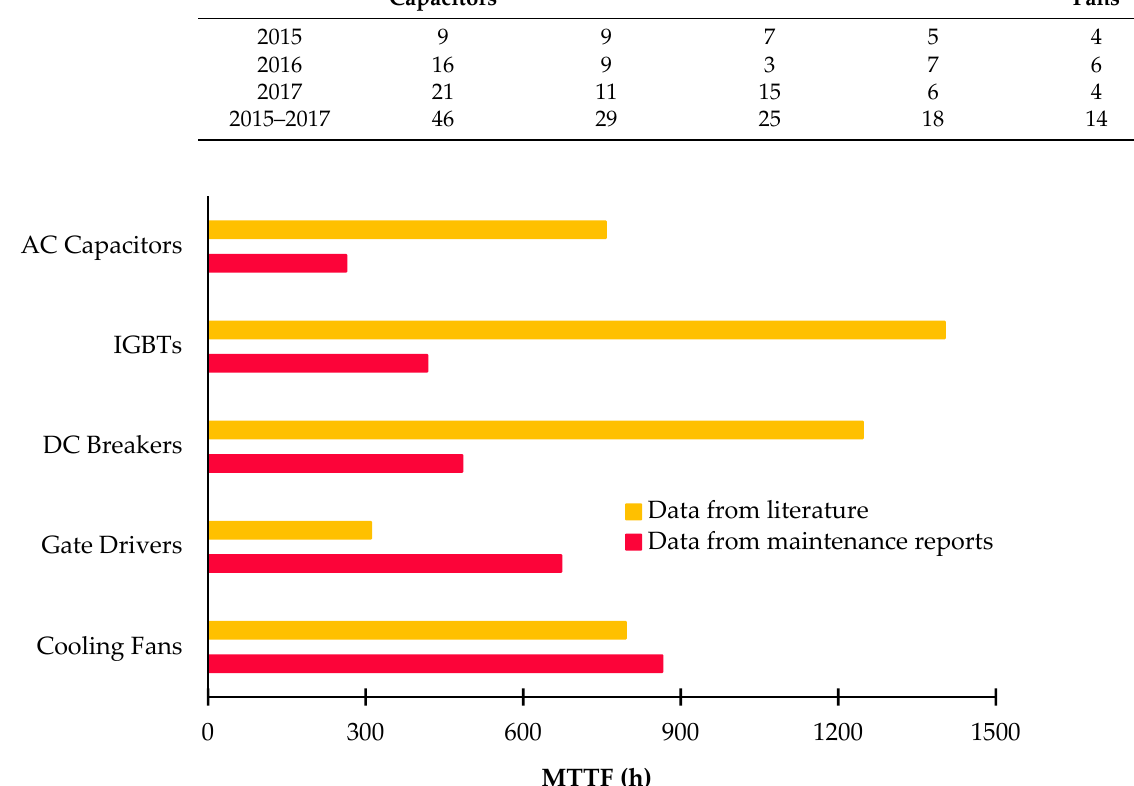
Figure 7. MTTF obtained using data from literature (yellow) and from maintenance reports (red).